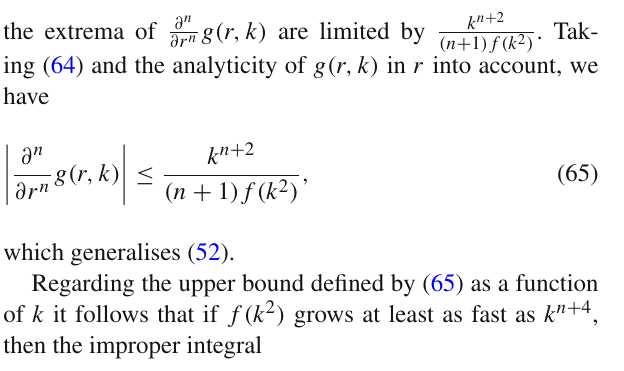
corresponding potential is at least 1-regular, regardless of the logarithmic corrections, as discussed